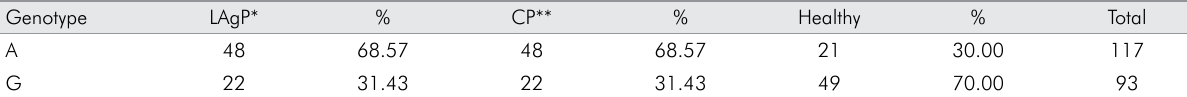
Table 4. Distribution of study subjects according to alleles and study